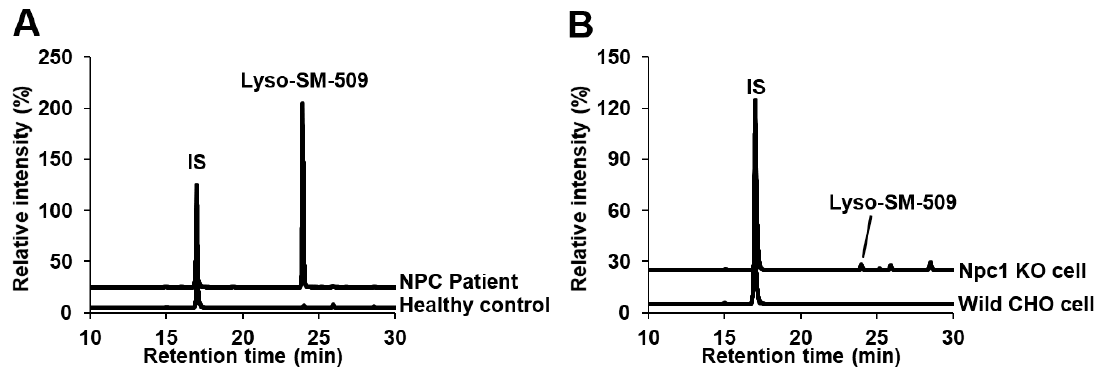
Figure 1. Selected reaction monitoring analysis for searching of Lyso-SM-509. ( A ) Typical total ion current chromatograms of serum. Upper, patient with Niemann–Pick disease type C (NPC); lower, healthy control. ( B ) Typical total ion current chromatograms of cells. Upper, Npc1 ( − / − ) gene trap CHO cell; lower, CHO cell.